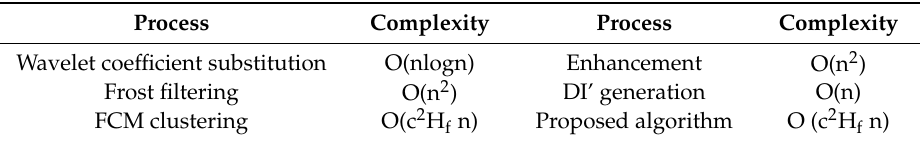
Table 3. Complexity of each